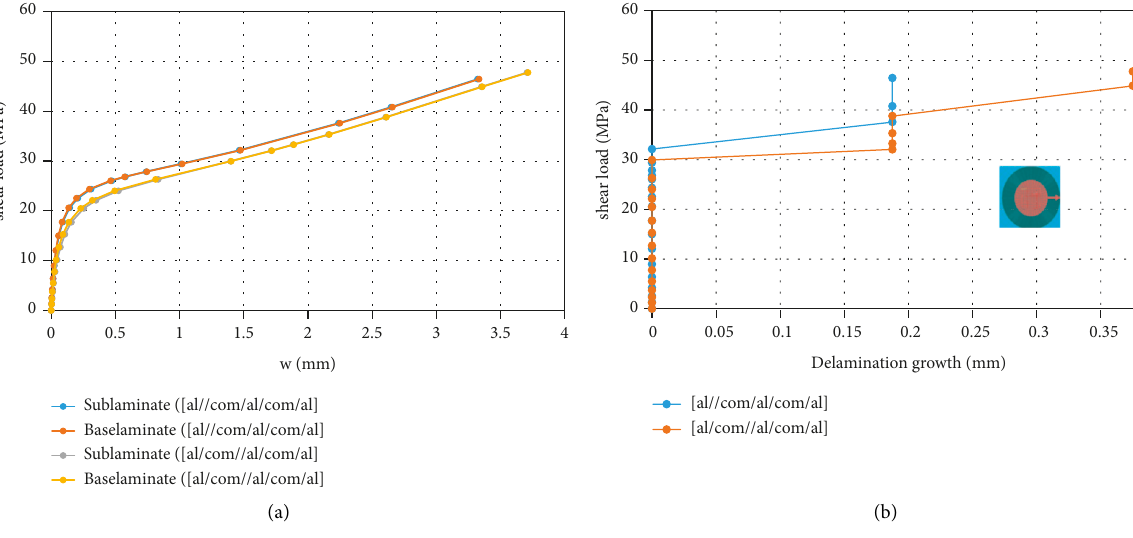
Figure 11: (a) Postbuckling behaviour of GALRE 3-3/2-0.4 and (b) delamination growth of GALRE